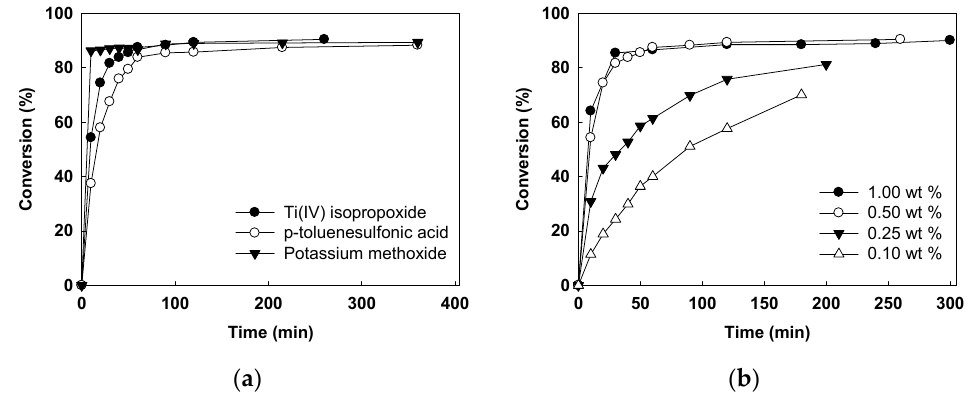
Figure 7. Effect of: ( a ) type of catalyst and ( b ) catalyst concentration. Reaction conditions: HE:ME molar ratio, 2:1; 120 °C, ( a ) 0.5% catalyst and ( b ) Ti(IV) isopropoxide as a catalyst.